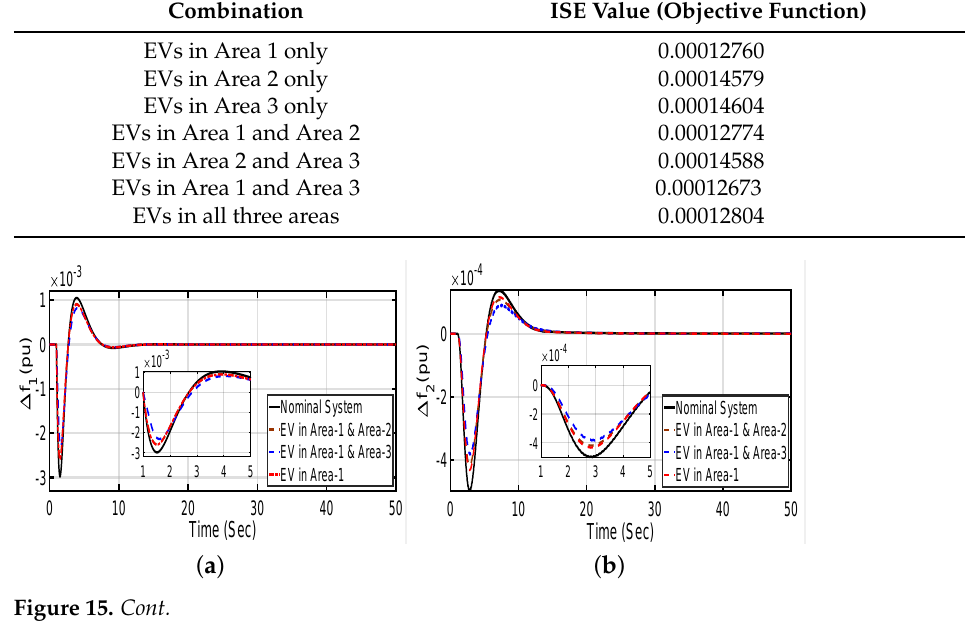
Table 4. ISE value for AOA optimized 1D-ADRC controlled HES for different combination of EVs.